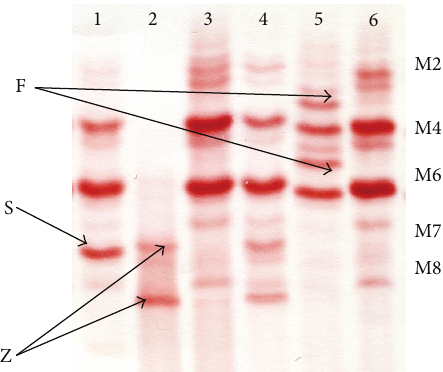
Figure 1: Examples of A1AT phenotype patterns, obtained by